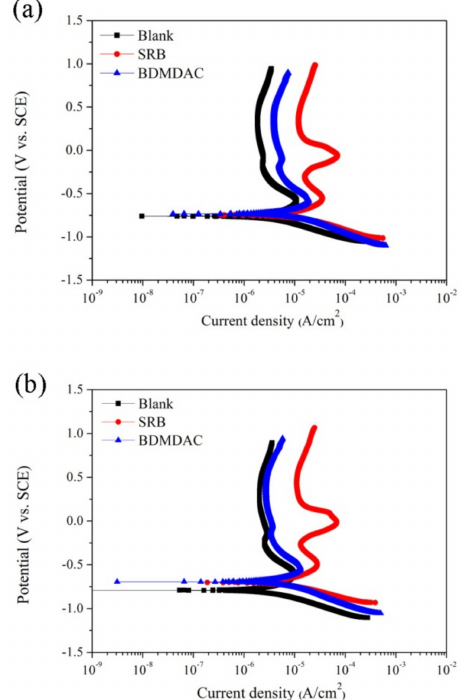
Figure 5. Potentiodynamic polarization curves for the 304SS coupons after 14 days ( a ) and 28 days ( b ) of immersion in various